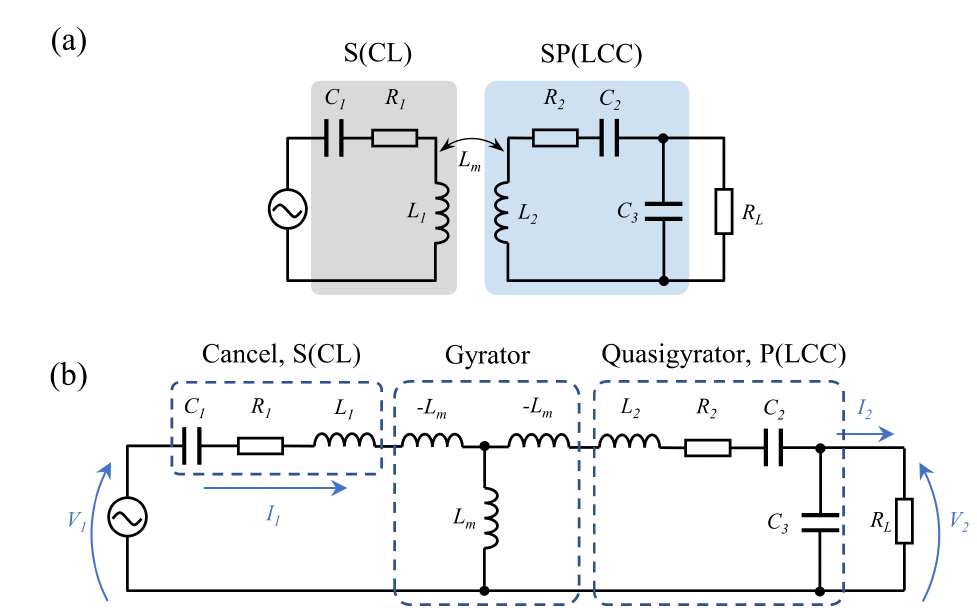
Figure 3. Circuit model of the S − SP topology WPT system. ( a ) System structure of S − SP topology WPT system, ( b ) equivalent circuit of S − SP